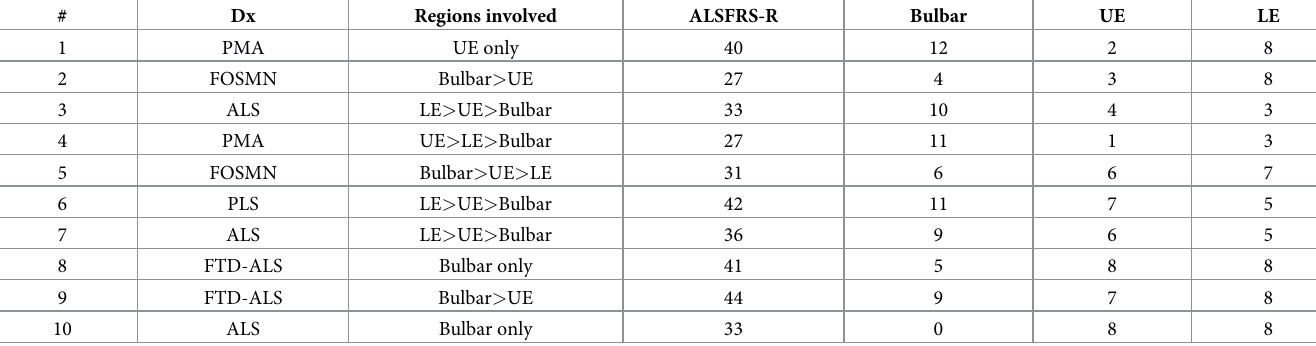
Table 2. Involved topographical anatomic regions and symptom severity in motor neuron disease